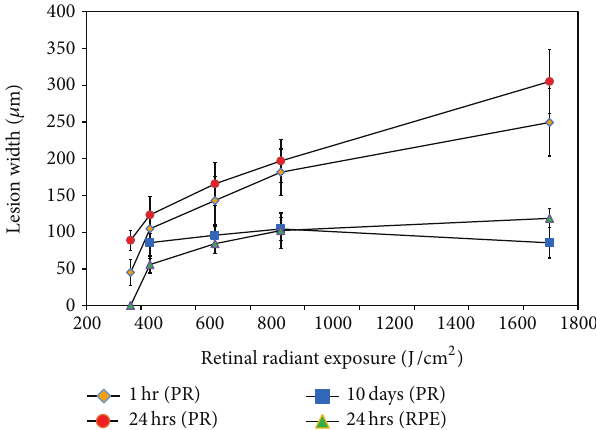
Figure 13: Plot of lesion width versus retinal radiant exposure to 413 nm light for one subject. Measurements were collected from AO SD-OCT enface imagesattheRPEandphotoreceptorlayerat1hour, 24 hours, and 10 days after exposure. PR: photoreceptor layer; RPE: retinal pigment epithelial